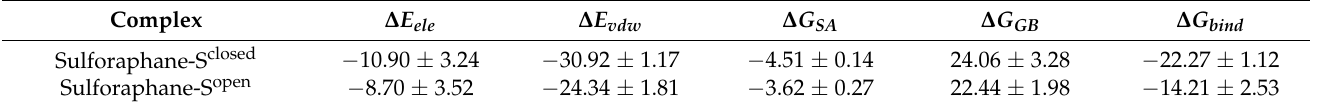
Table 2. Binding free energies ( ∆ G bind ) and their components of docked complexes 1